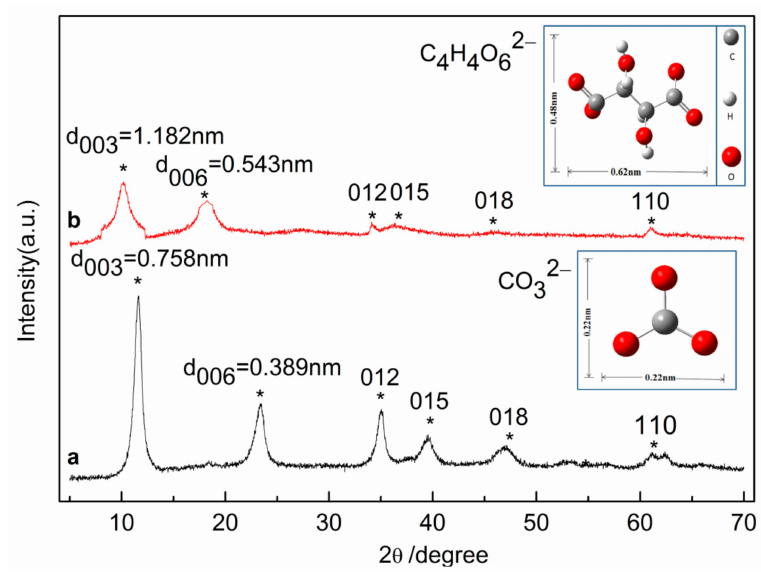
Figure 4. XRD diffraction of samples. ( a ): Zn 2+ -Al 3+ -C 2 − -LDHs; ( b ): Zn 2+ -Al 3+ -C 2 H 42 − -LDHs. The morphology of the Zn 2+ -Al 3+ -C 4 H 4 O 62 − -LDHs was observed by SEM, shown in Figure 5. The sample demonstrated a similar lamellar structure with different magnification of 2.5kx (a) and 10.0 kx (b). Meanwhile, a uniform appearance and a regular shape collection with integrated hexagons are presented in Figure 5b. The EDS analysis in Figure 5c shows all the elements contained in Zn 2+ -Al 3+ -C 4 H 4 O 62 − -LDHs, which can be calculated from the weight or element proportion of Zn 2+ and Al 3+ conformed to 2:1, and the existence of carbon and oxygen originated from the successful intercalation of C 4 H 4 O 62 − .